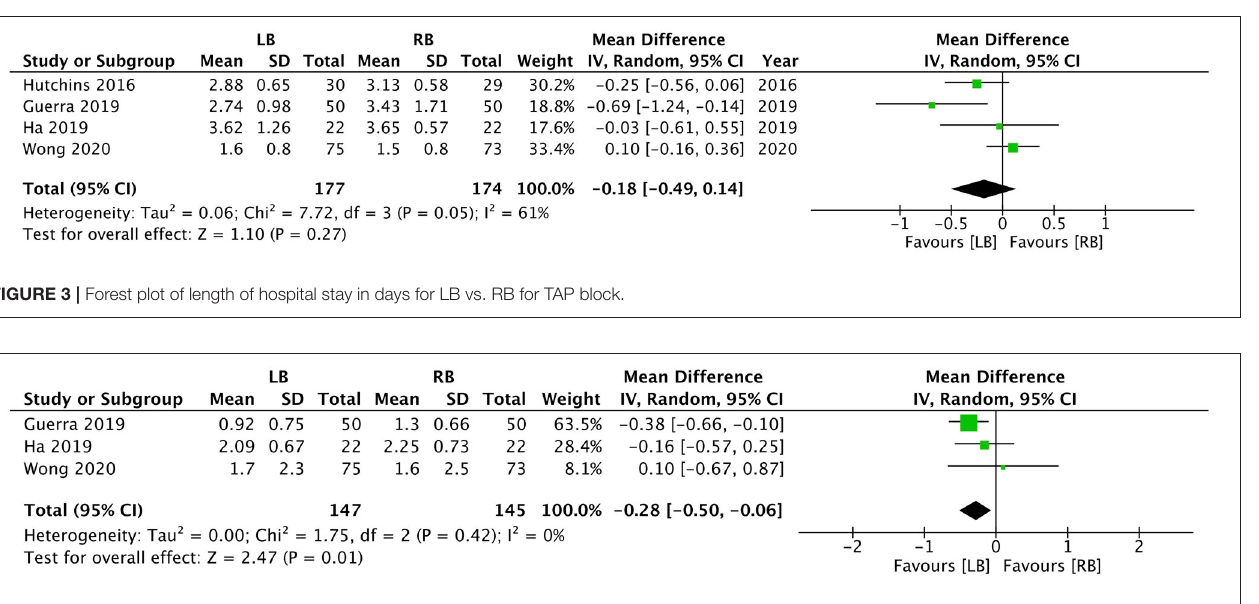
FIGURE 4 | Forest plot of time to unassisted ambulation in days for LB vs. RB for TAP block.